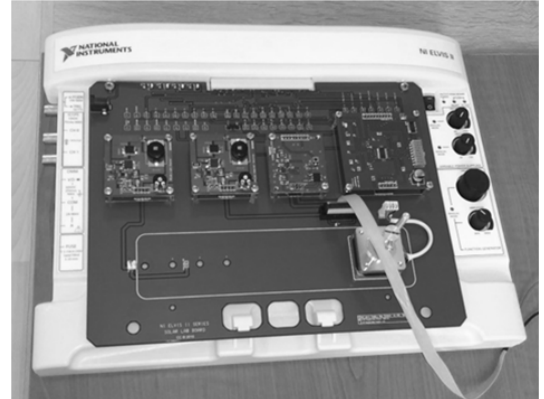
Figure 5. Data acquisition system NI Elvis II